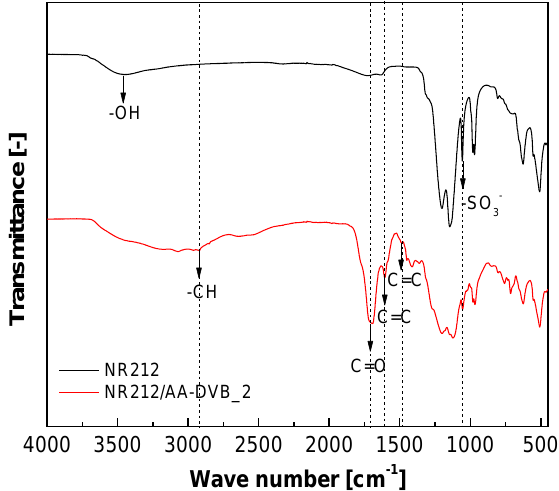
Figure 5. FT-IR spectra of NR212 / AA-DVB_2 membrane compared with that of NR212.